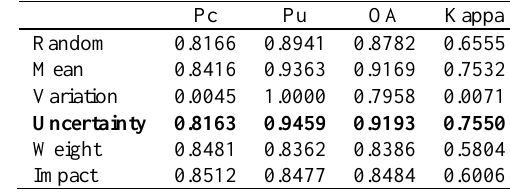
Table 2. The comparison of change detection results for different query strategies with active learning.